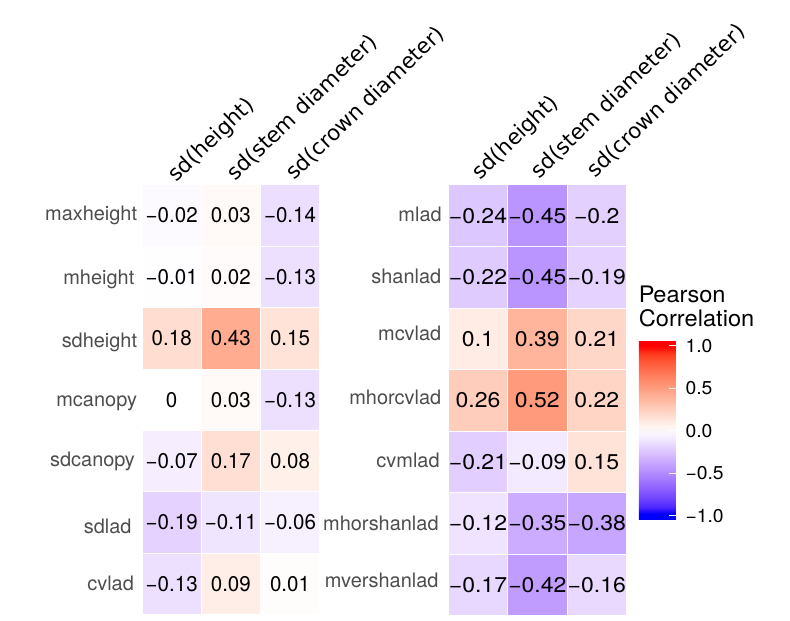
Figure 3. Pearson correlation coefficient between lidar-derived metrics and the standard deviation of the three field-based vegetation structure